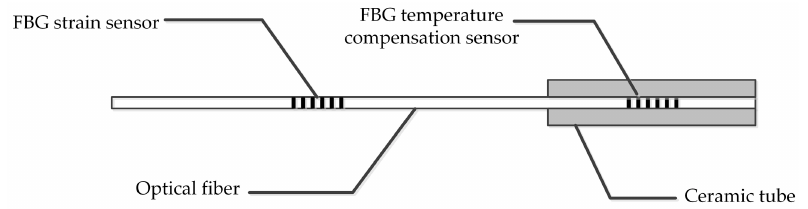
Figure 2. The FBG packing method.